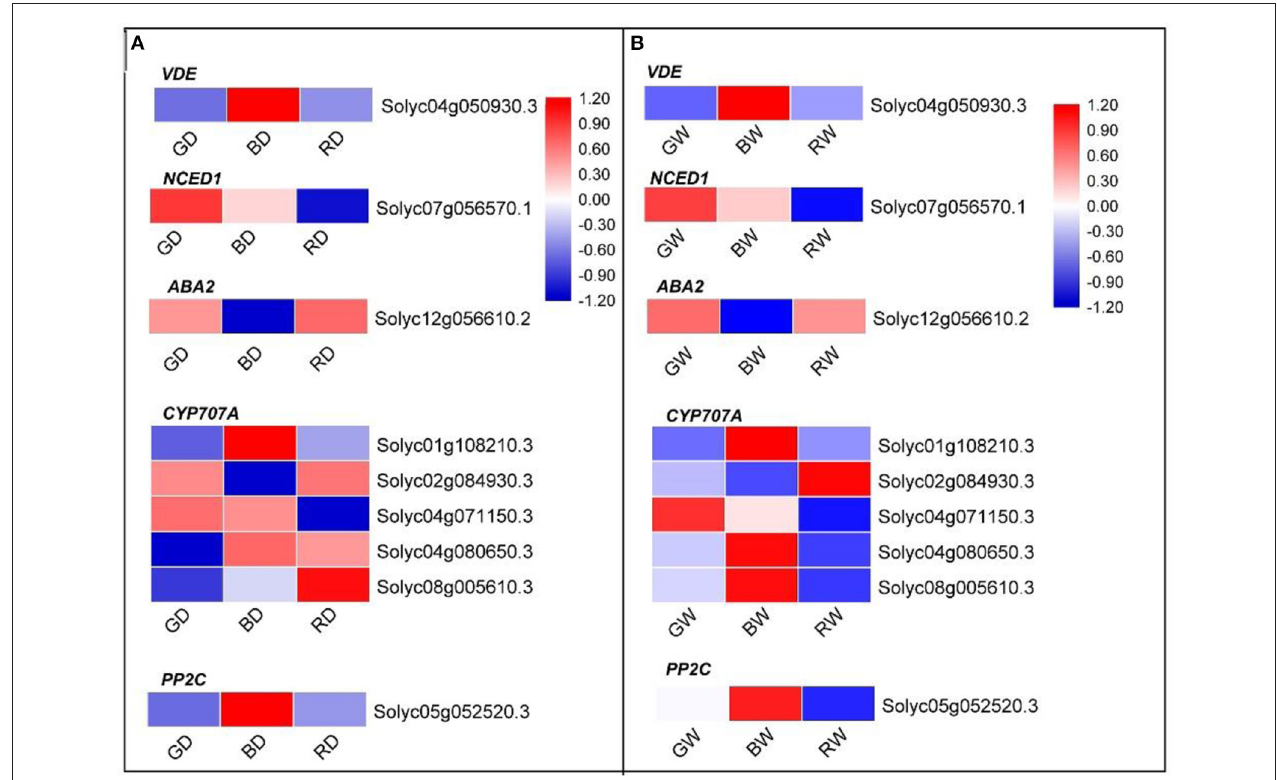
FIGURE 8 | The heatmap diagram of relative expression profiles of DEGs involved in ABA synthesis and ABA signaling transduction in response to red, blue, and green light under drought conditions (A) and well-water conditions (B). Gene expression is shown in a heatmap with color scale representing log 2 (FPKM) (blue: low expression level; red: high expression level). A scale indicating the color assigned to log 2 (FPKM) is shown to the right of the